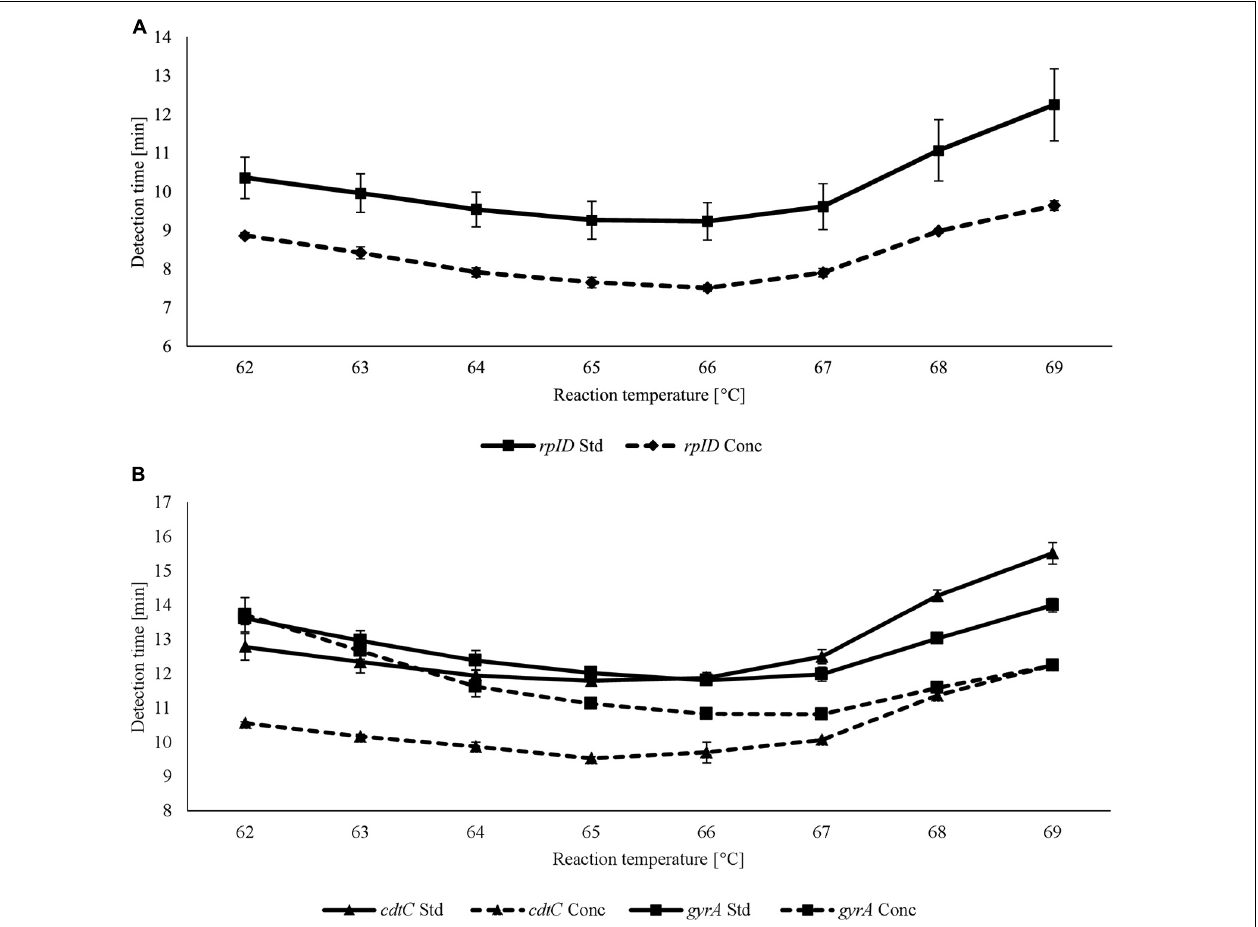
FIGURE 1 | Detection times achieved using standard (Std) and concentrated (Conc) rplD (A) and cdtC and gyrA (B) primer mixes at different reaction temperatures. Error bars represent the standard deviation of three independent measurements.